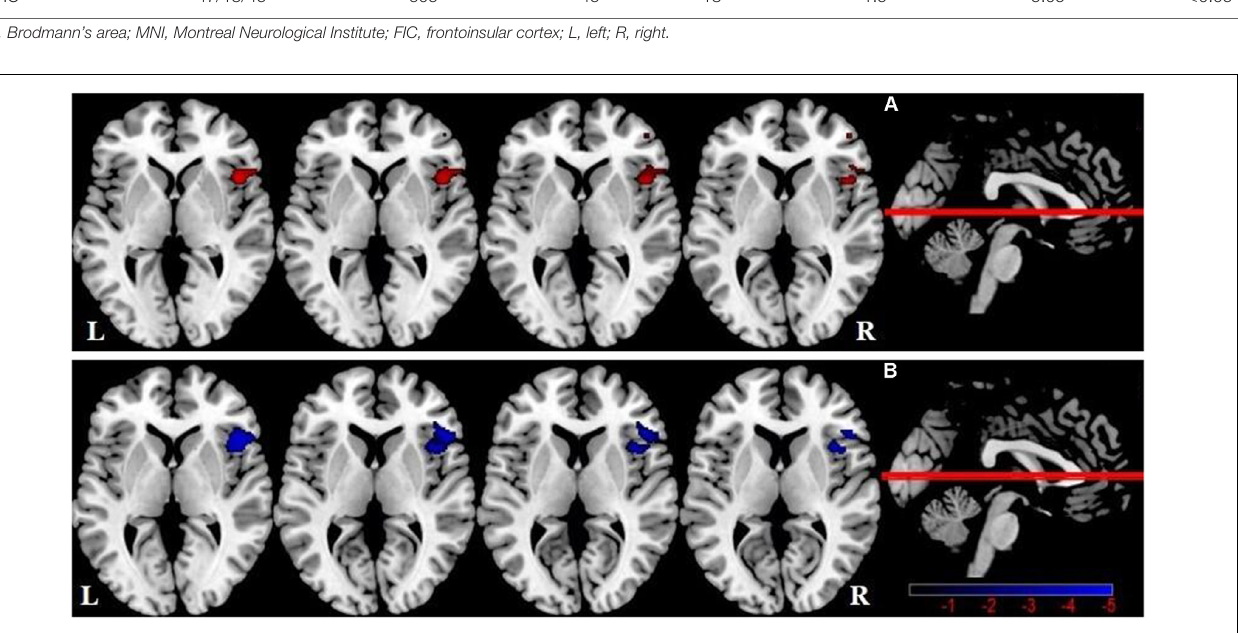
FIGURE 2 | Salience network brain regions with differences in gray matter volume (GMV) among the three groups ( P < 0.05, GRF-corrected). (A) A one-way ANOVA showed SN brain regions with GMV differences between the three groups. (B) Differences in GMV within the SN between DMCI patients and DMCN